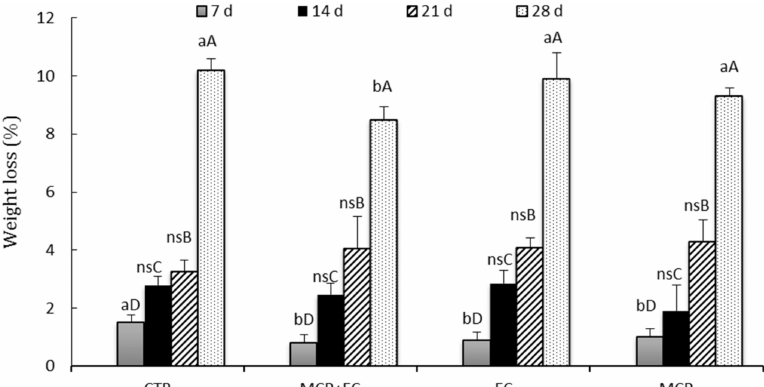
Figure 4. Evolution of fruit treatments on weight loss (%) in white flesh melting peaches ( P. persica ) cv Settembrina treated with the edible coating (EC) with 1-MCP + EC, 1-MCP (MCP) and untreated (CTR) stored at 1 ◦ C for 7, 14, 21, and 28 days. Data correspond to the means ± standard error (SE) of 15 replicates. Means with di ff erent letters are significantly di ff erent at p ≤ 0.05 using Tukey’s test. ns = not significant. Di ff erent lowercase letters denote significant di ff erences ( p ≤ 0.05) among di ff erent treatments for the same sampling time. Di ff erent capital letters denote significant di ff erences ( p ≤ 0.05) among di ff erent sampling times for the same